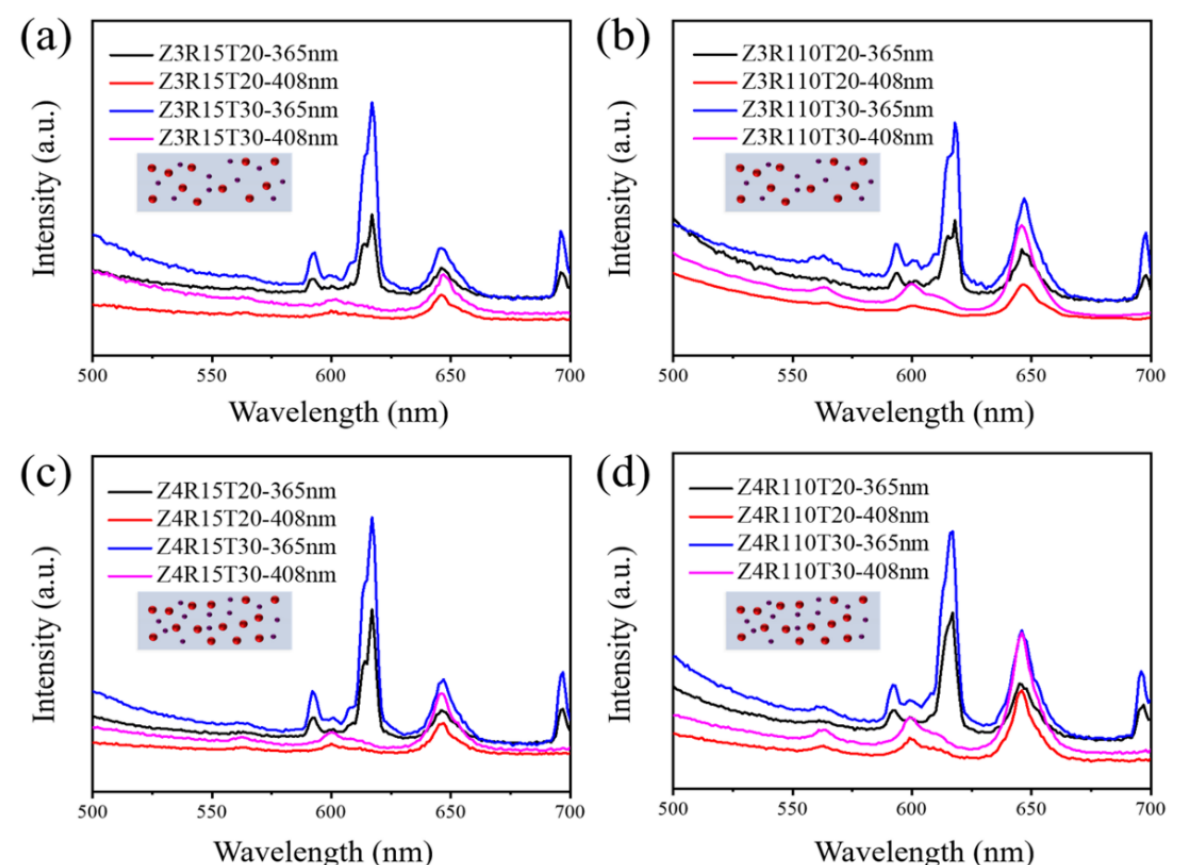
Figure 9. ( a ) Emission spectra of Z3R15T20 and Z3R15T30 upon the excitation at 365 and 408 nm, respectively. ( b ) Emission spectra of Z3R110T20 and Z3R110T30. ( c ) Emission spectra of Z4R15T20 and Z4R15T30. ( d ) Emission spectra of Z4R110T20 and Z4R110T30.